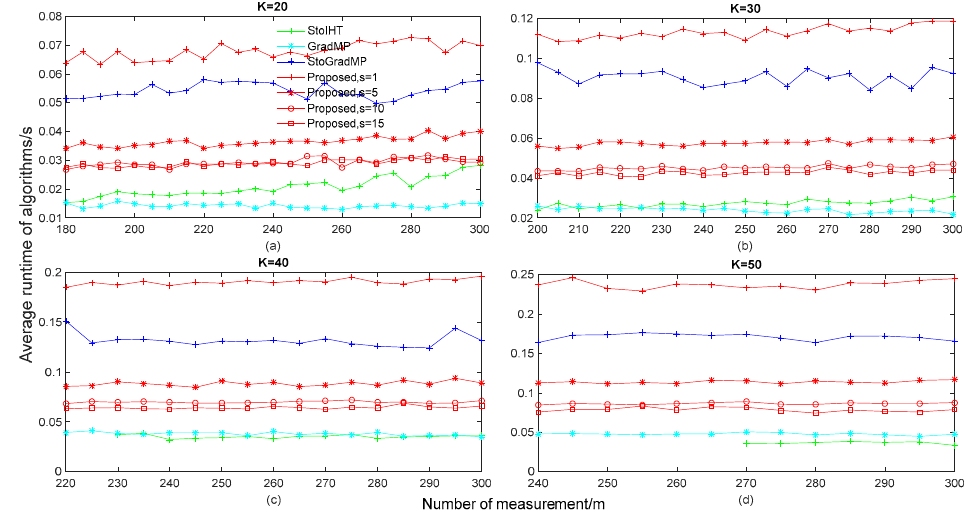
Figure 8. The average runtime of different algorithm with different measurements in different sparsity conditions ( n = 400, s ∈ [ 15,10,15 ] , δ K = 0.1 and m = 2 ∗ K : 5 : 300, Gaussian signal).